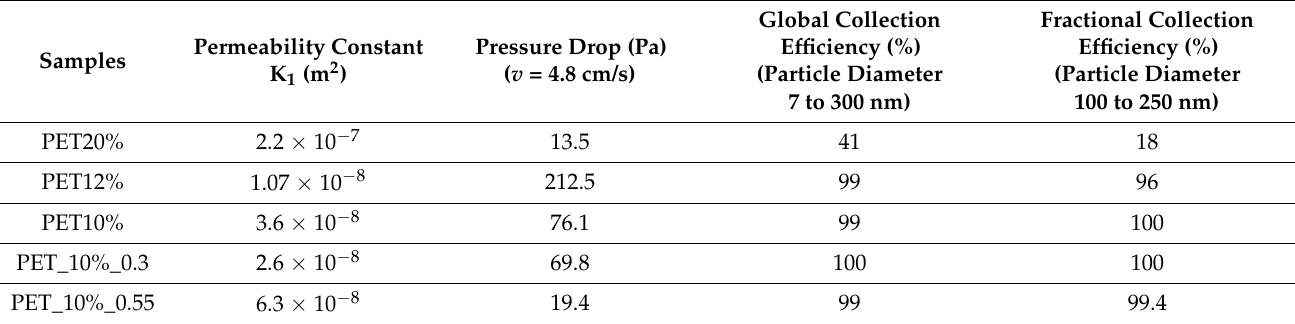
Table 4. Characteristics of performance